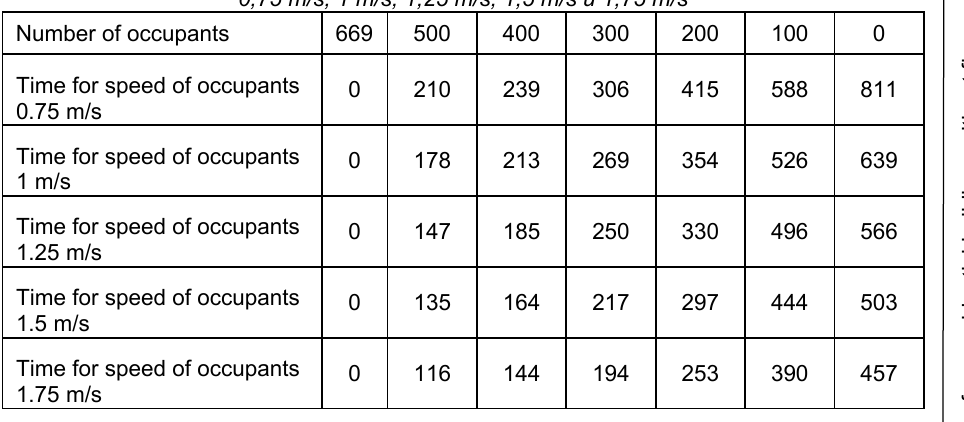
Table 7 – Simulation results in seconds for the second scenario, with elevators disabled and the first entrance/exit blocked and for the occupants’ speeds from 0.75 m/s, 1